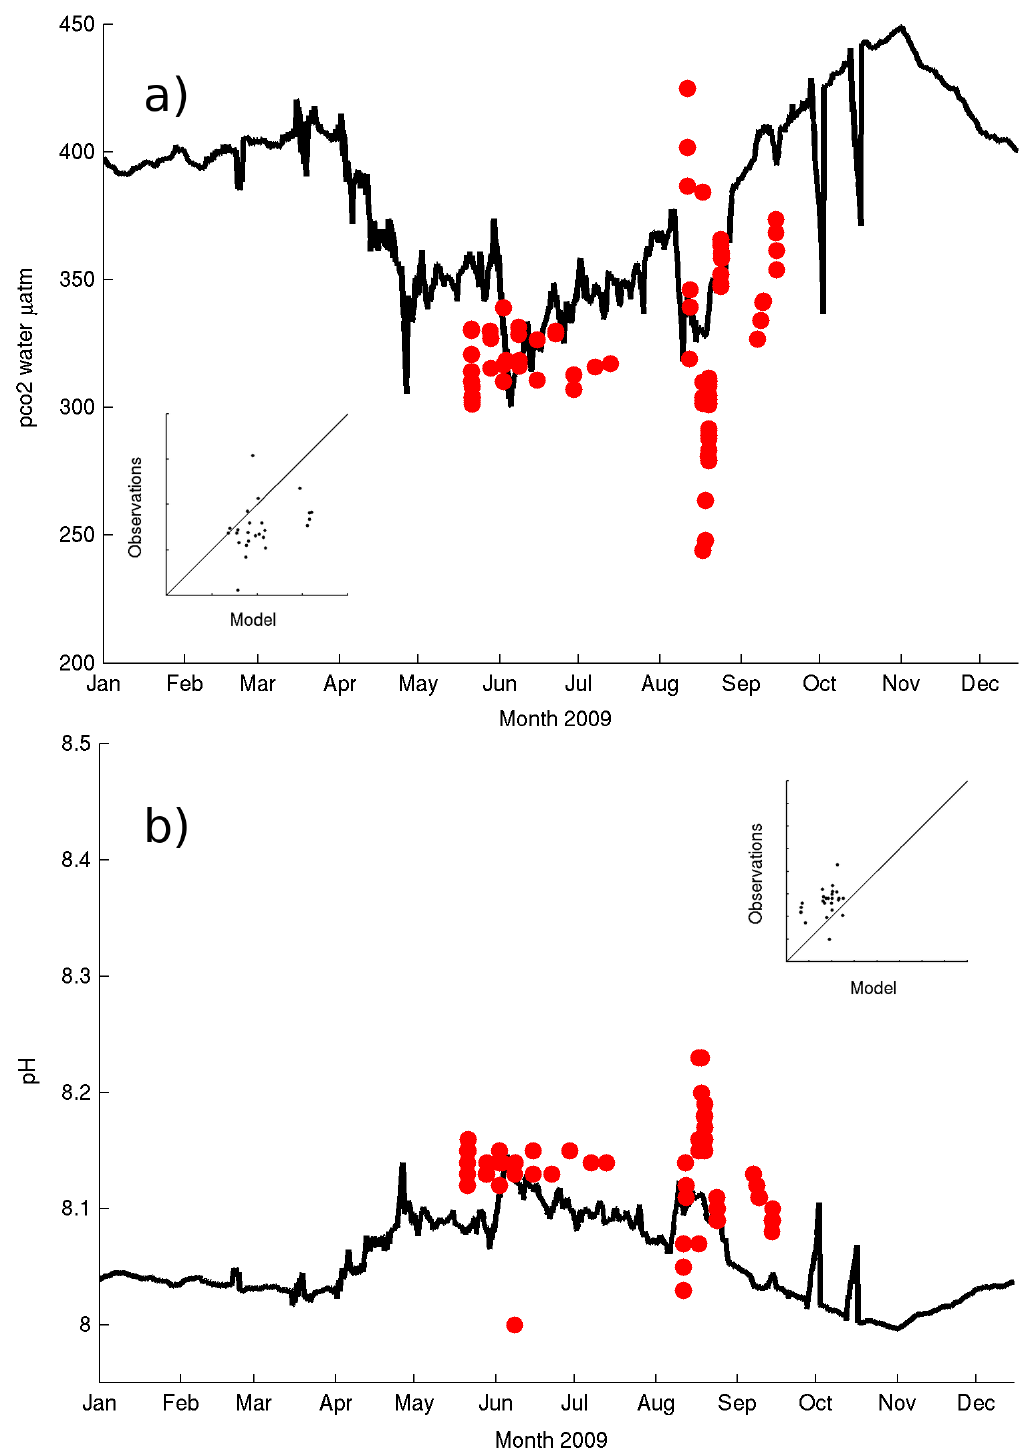
Figure 7. Evolution at 2 m of ( a ) in-water CO 2 partial pressure and ( b ) in-water pH. The observations correspond to the red dots while the model is the solid line. The one to one plot between observations and model results is included as a thumbnail to illustrate the correspondence between the